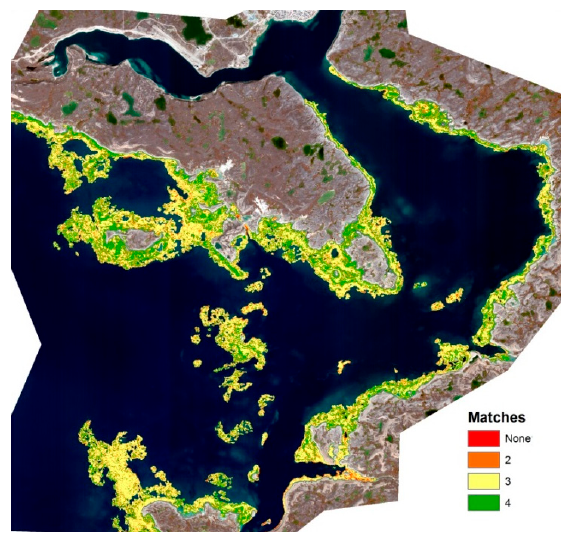
Figure 6. Visualization of locations where four, three and two SDB techniques agree within 1 m. Imagery © 2015, DigitalGlobe, Inc.